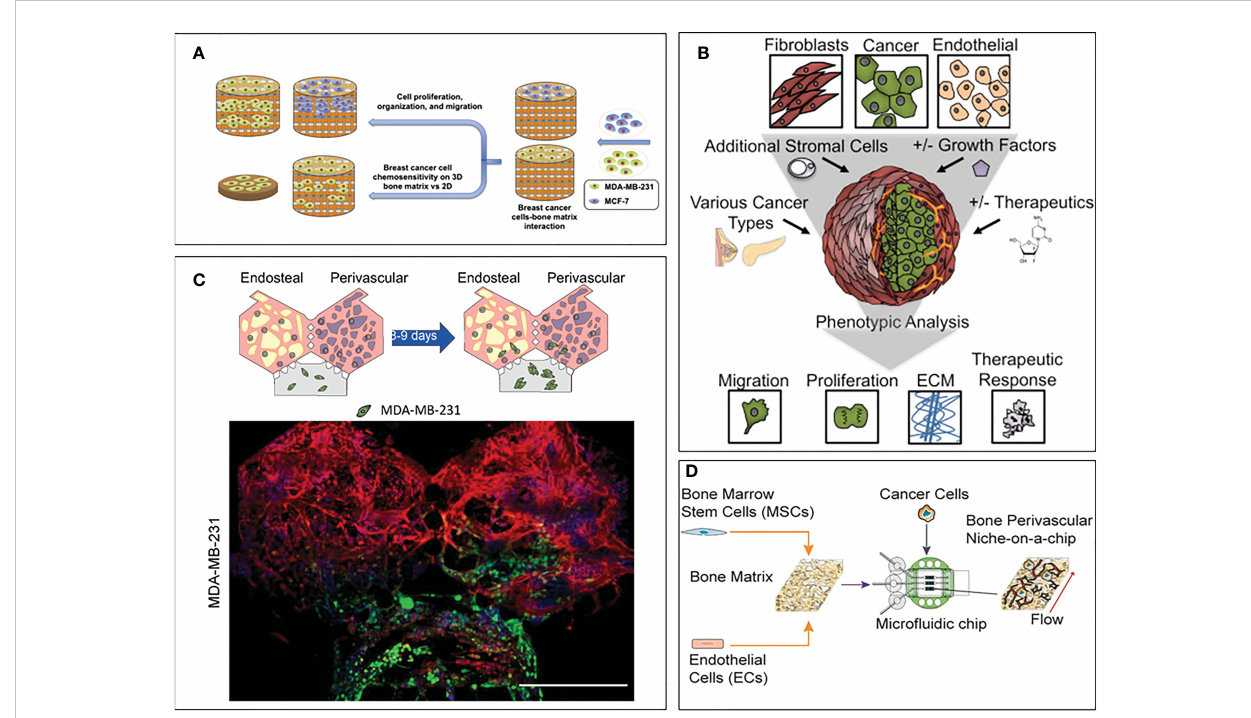
FIGURE 2 3D models focusing on drug sensitivity in breast cancer bone metastasis. (A) Model by Zhu et al. (114). Breast cancer cells and bone marrow MSCs were seeded on a bone matrix and showed drug resistance in presence of the microenvironment compared to the 2D culture. (B) Model by Langer et al. (119). Breast cancer cells were seeded with fi broblasts, endothelial cells, adipocytes and bone marrow MSCs. Increased cancer cell aggressiveness and drug resistance were observed compared to the 2D control. (C) Model by Glaser et al. (121). Breast cancer cells were seeded with bone marrow MSCs, osteoblasts, HSCs and endothelial cells. Differences in cell behavior were observed when breast cancer cells were co-cultured with bone and stromal cells compared to fi brin only hydrogels. (D) Model by Marturano-Kruik et al., (120). Cancer cells showed drug resistance when exposed to interstitial fl